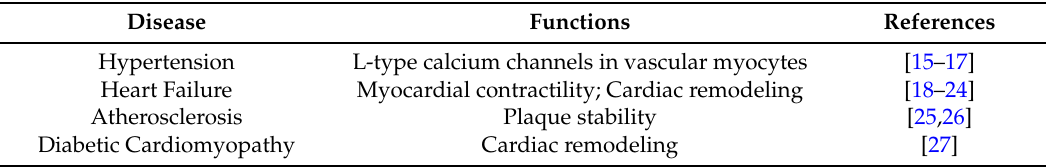
Table 1. PI3K γ involvement in cardiovascular diseases.